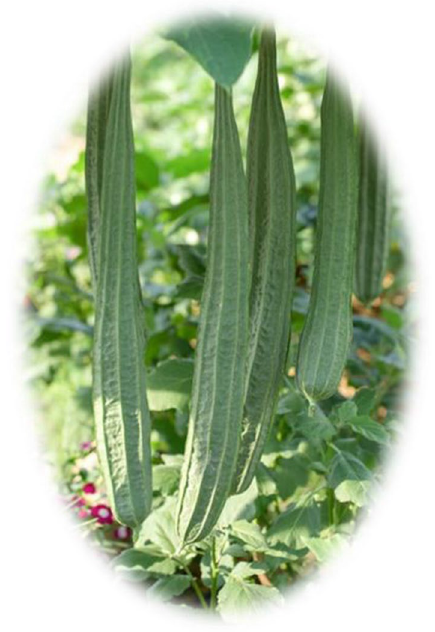
Fig. 15 Extracts of the sponge guard used as a coagulant